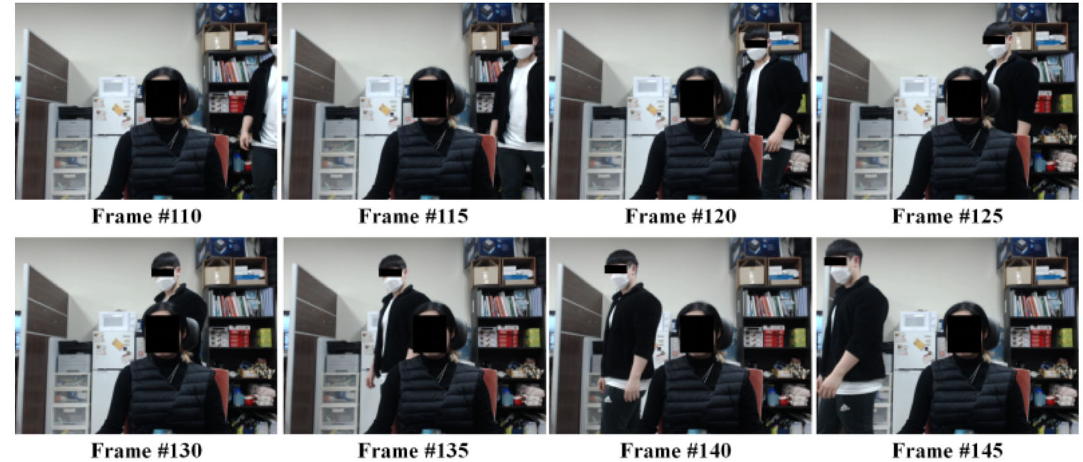
Figure 9. Example of respiration dataset with motion and background noise.